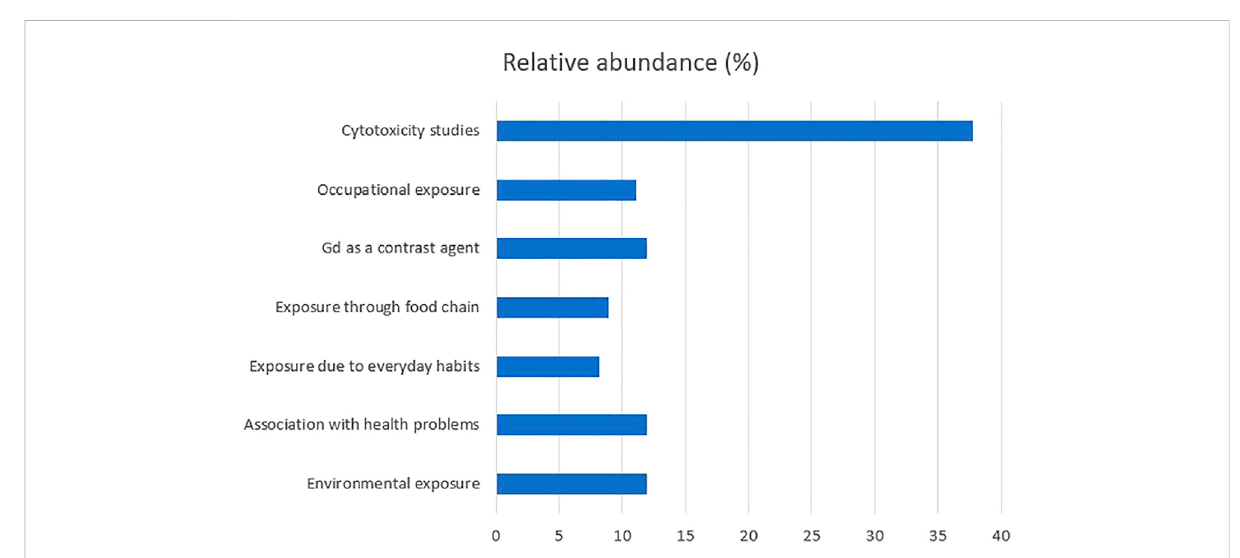
FIGURE 1 Comparison of the relative abundance (%) of papers for each section studied in response to